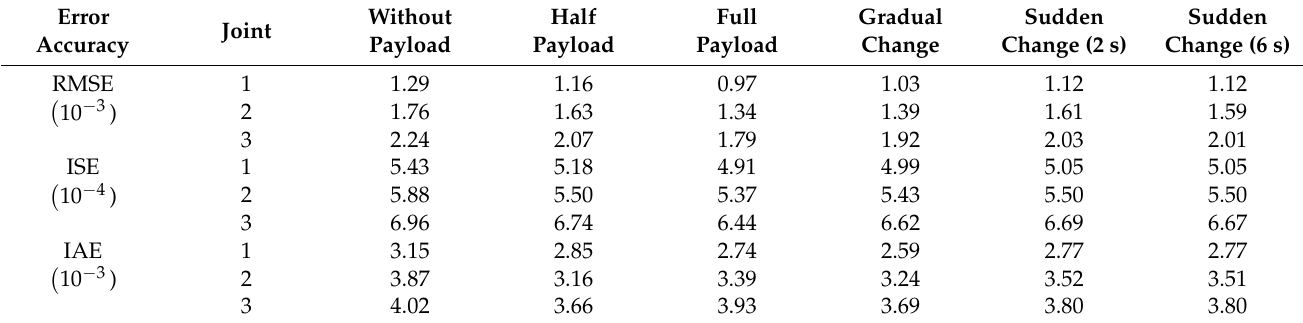
Table 4. Controller performance comparisons with